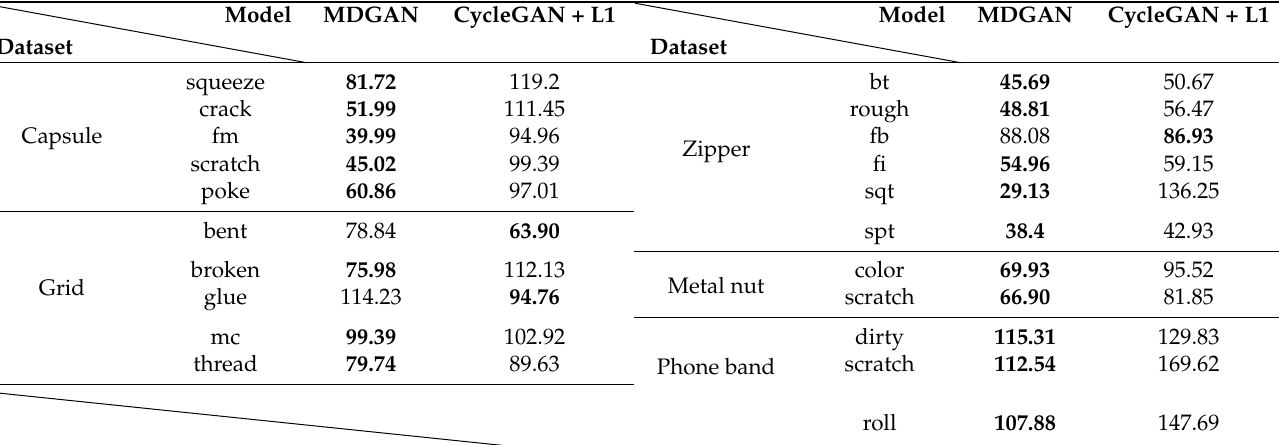
Table 3. FID between generated results and real images. Bold fonts indicate better